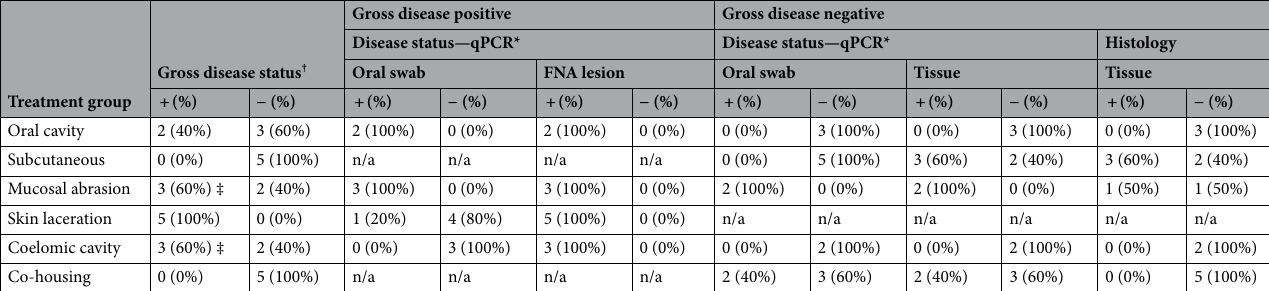
Table 3. Prevalence of gross lesions and infection status of Asian house geckos experimentally challenged with E. lacertideformus by six different inoculation methods. The type of diagnostic method used (qPCR or histology), and the type of sample tested by each method (oral swab, FNA lesion, or tissue) based on the gross disease status of the gecko are displayed in the headers of the table. All remaining geckos confirmed grossly positive for E. lacertideformus were enlisted into the antibiotic treatment trial. +, positive for E. lacertideformus ; −, negative for E. lacertideformus. † A gecko was defined as grossly positive for E. lacertideformus when an FNA cytology of the lesion demonstrated characteristic organisms. *A gecko was defined as qPCR positive for E. lacertideformus when the oral swab and/or FNA of the gross lesion tested returned a positive result. ‡ A gecko grossly positive for E. lacertideformus infection but not included in the antibiotic treatment trial (mucosal abrasion, n = 3; coelomic cavity, n =